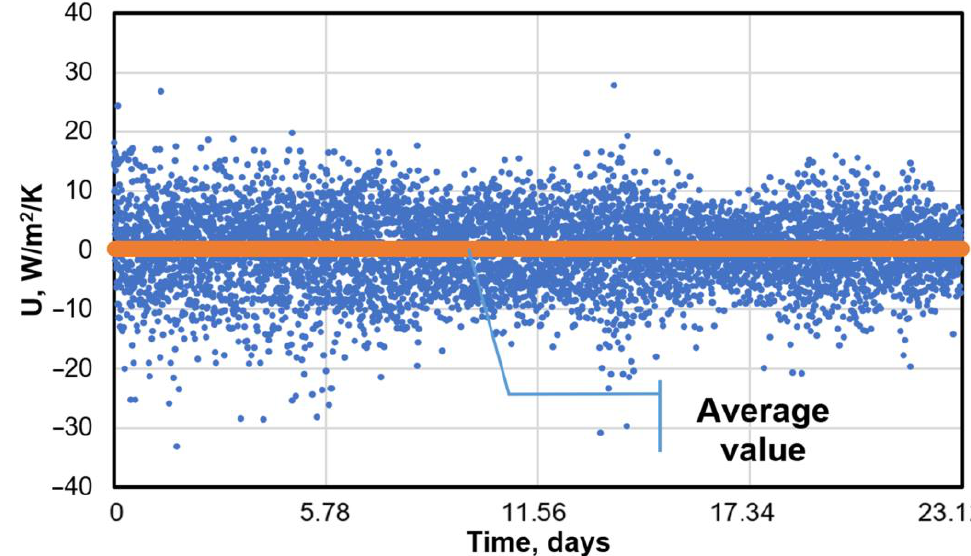
Figure 7. Values of heat transfer coefficient U vs. time.